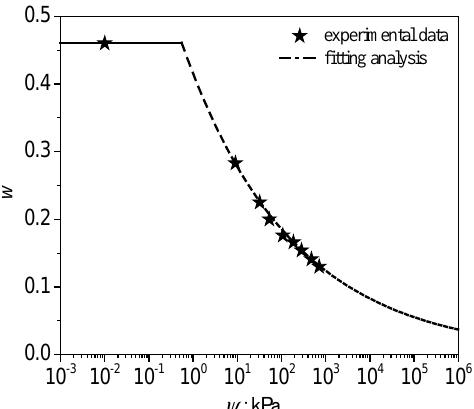
Figure 19. Determination of air-entry values at reference state through fitting Equation (12) to the experimental SWCCs for loess with e 0 = 1.230.